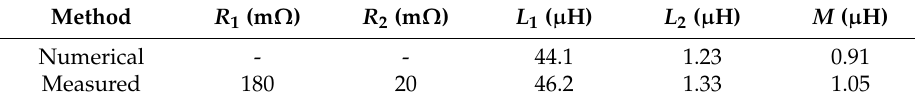
Table 1. Measured and calculated parameters of the WPT equivalent circuit parameters.